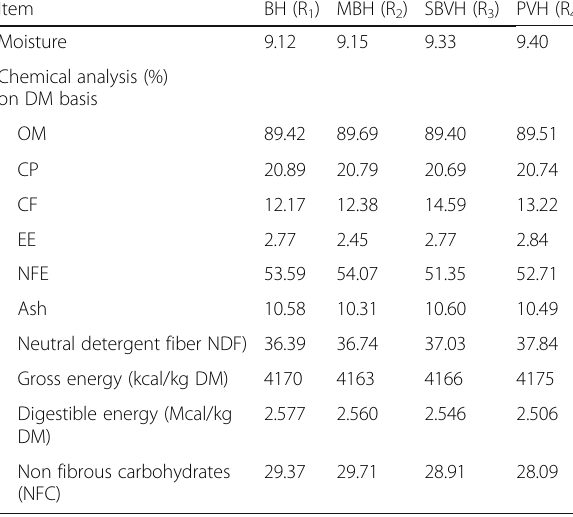
Table 2 Chemical analysis of the experimental rations